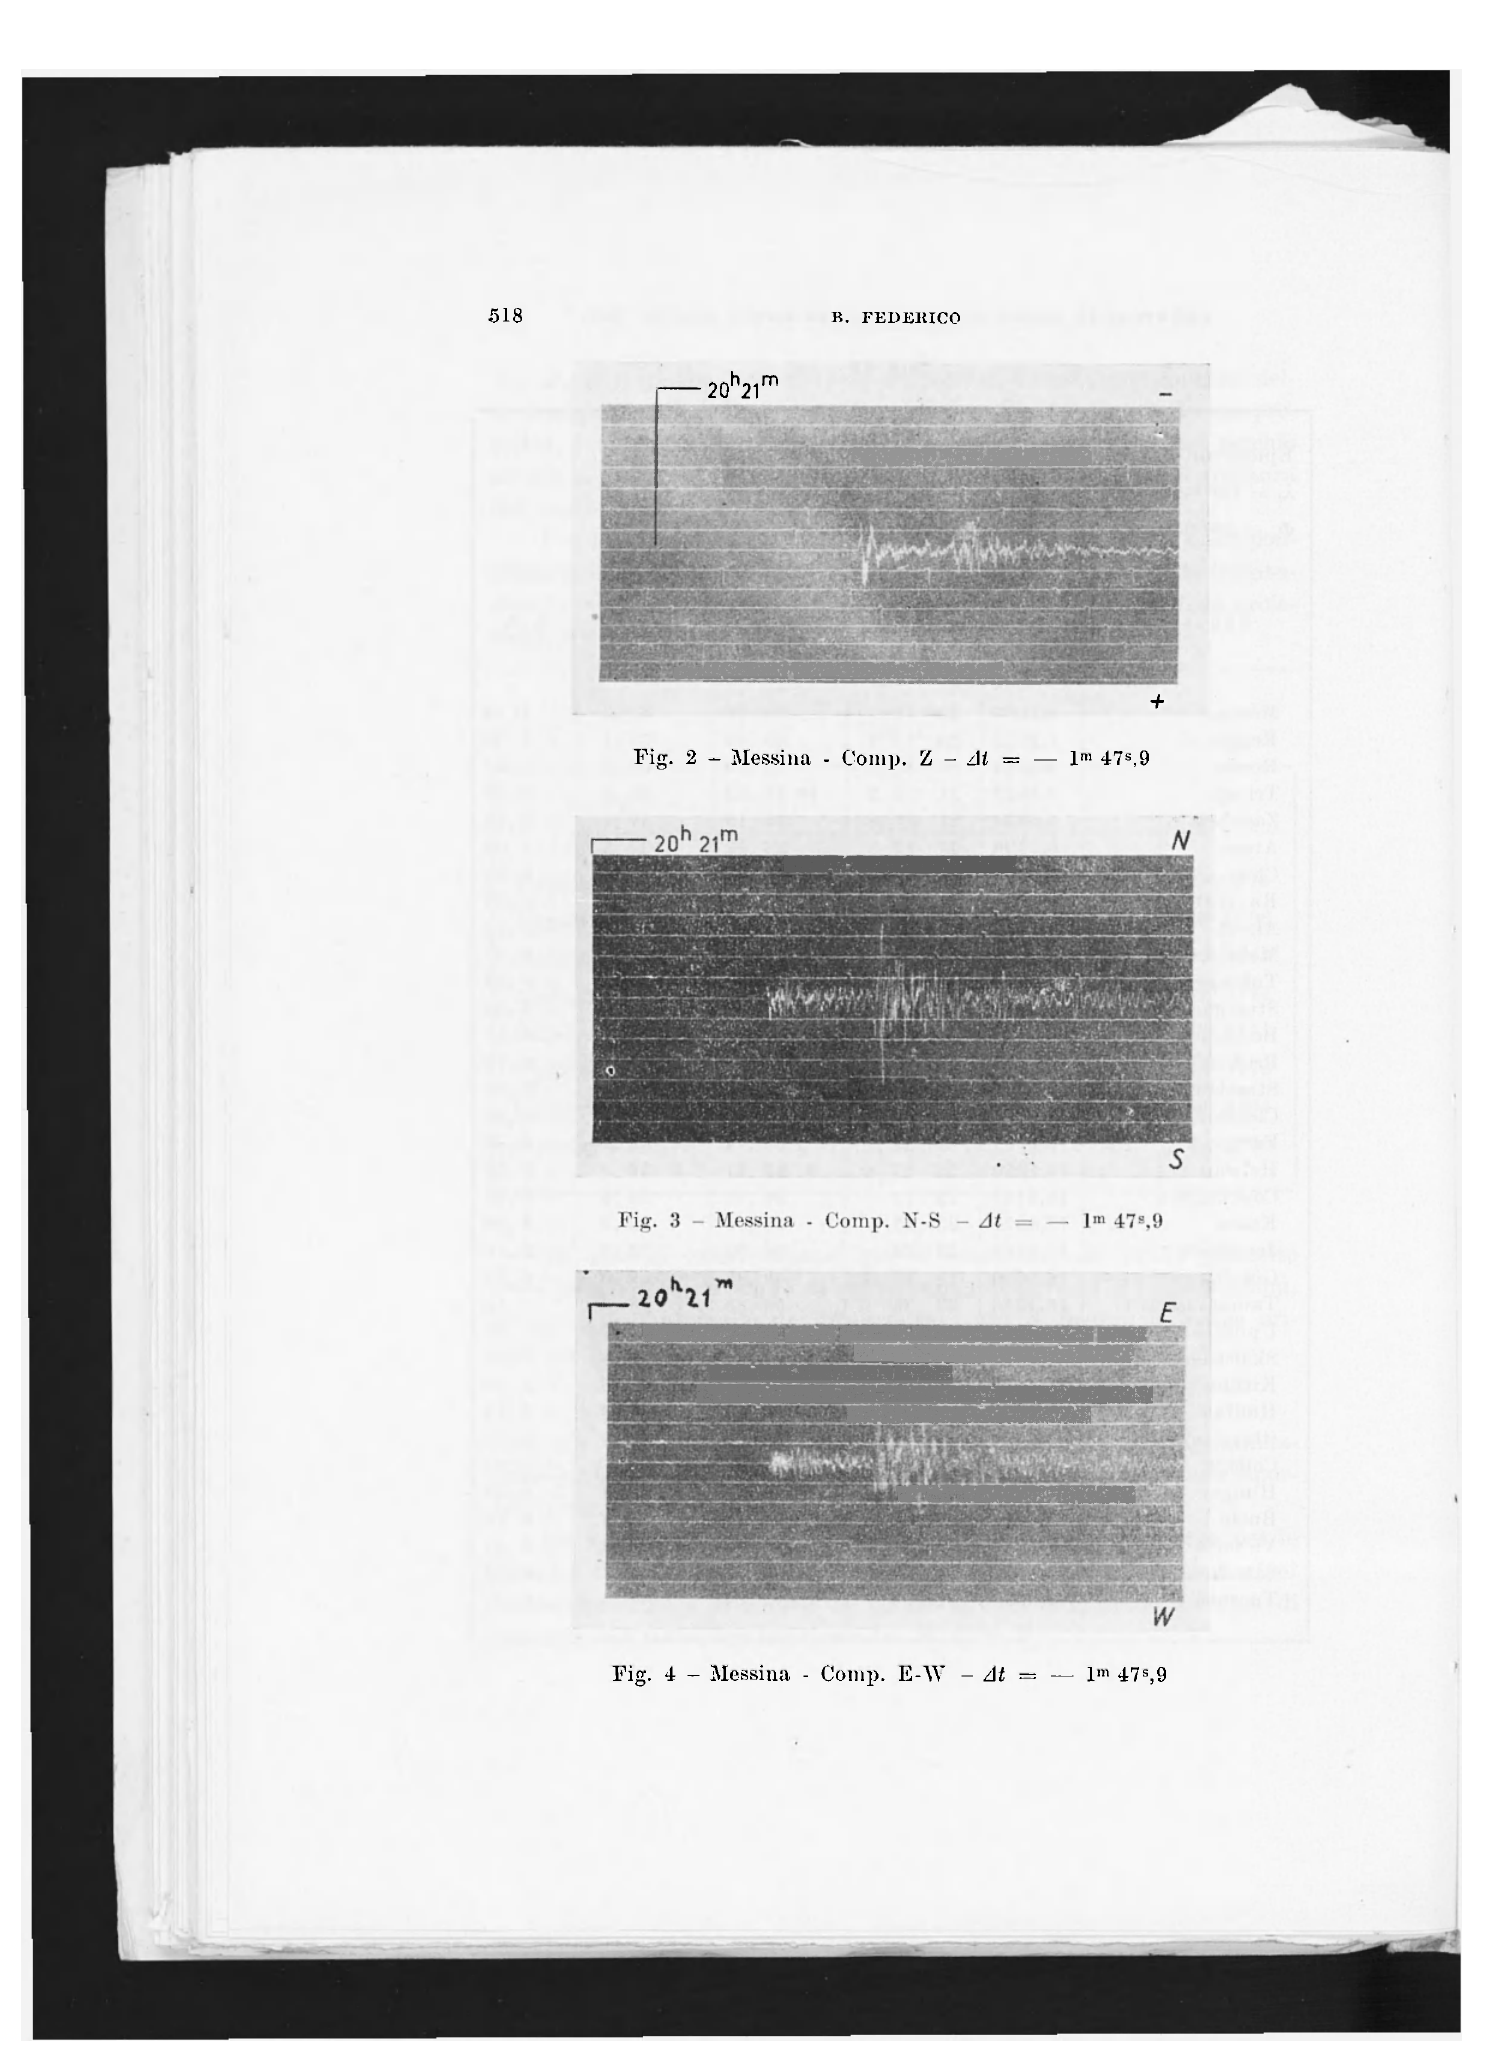
Fig. 4 - Messina - Comp. E-W - At = — l m 47 s